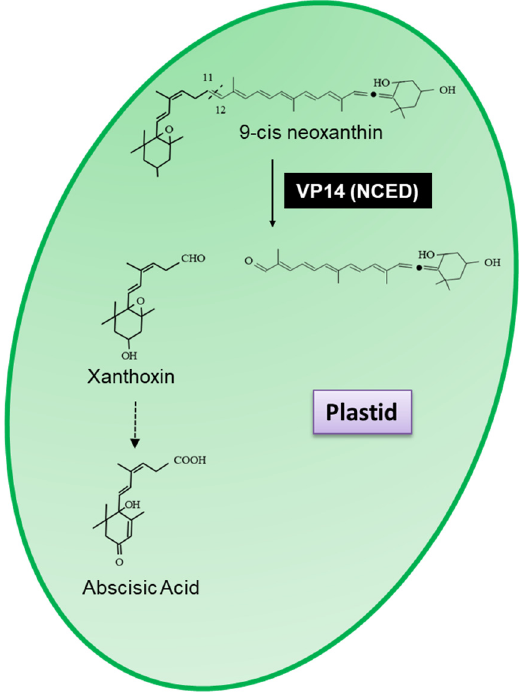
Figure 2. Scheme for the 11,12-cleavage reaction catalysed by VP14 (9-cis-epoxycarotenoid dioxygenase) resulting in the formation of xanthoxin, the precursor of abscisic acid. Tan et al. [189] identified nine members of the VP14 family in Arabidopsis, five of which have been shown to cleave neoxanthin at the 11,12 double bond and have thus been